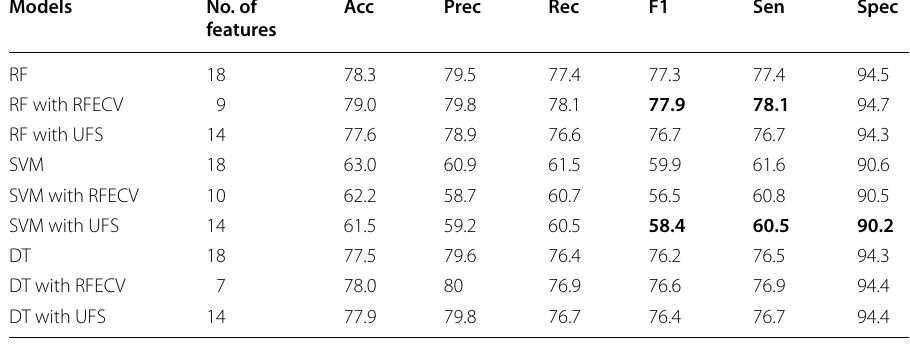
Table 6 Multiclass classification results without and with feature selection Models